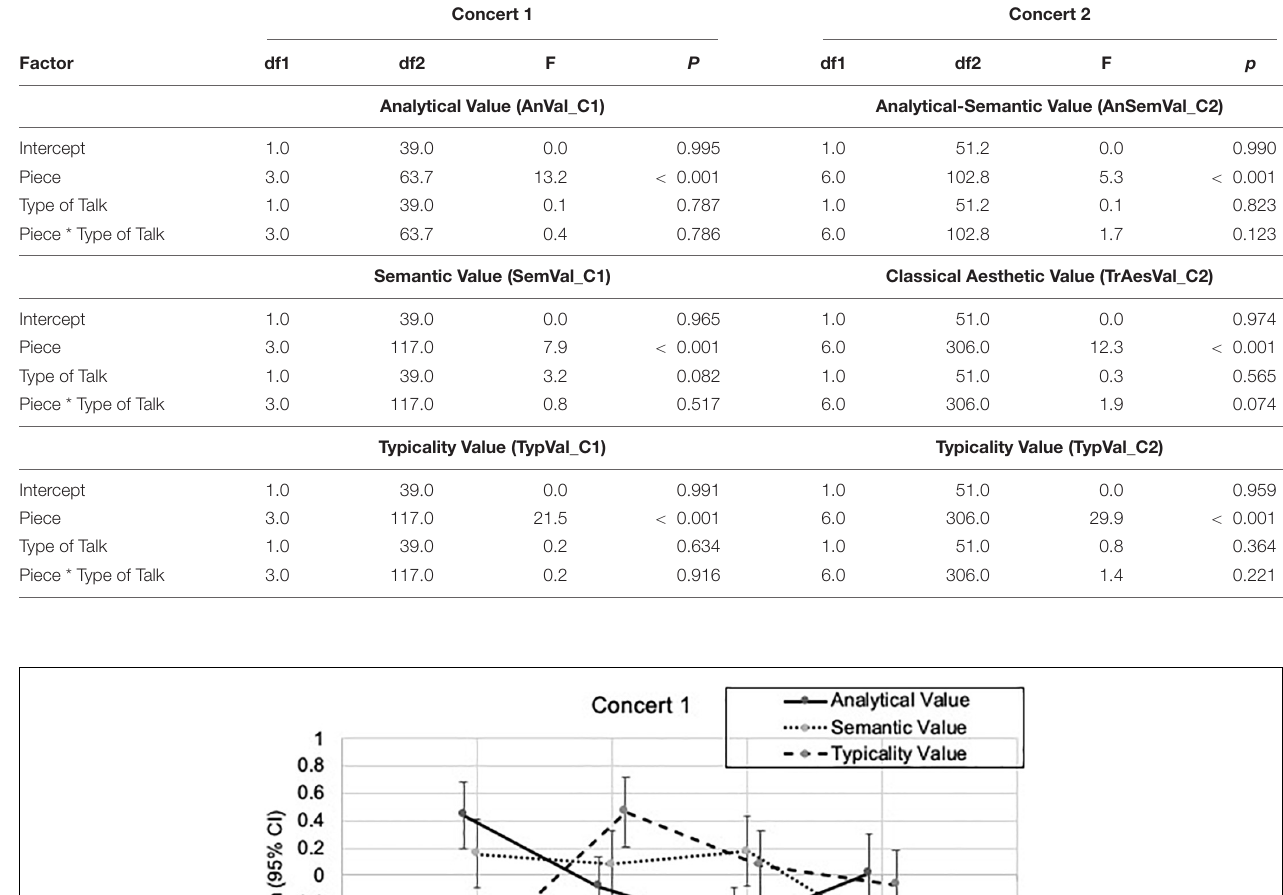
TABLE 5 | Hierarchical linear models testing for effect of type of pre-concert talk and piece of music on aesthetic judgment value factors.